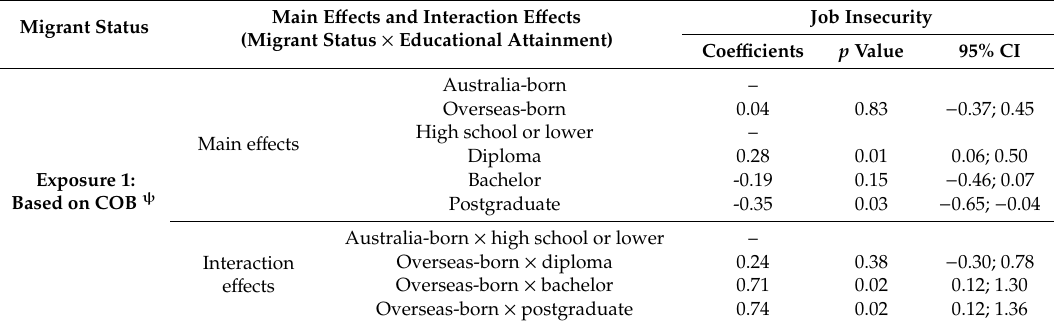
Table A2. The main e ff ects and interaction e ff ects of migrant status and educational attainment of the relationships between migrant status and job insecurity, adjusted for gender and age ( n =